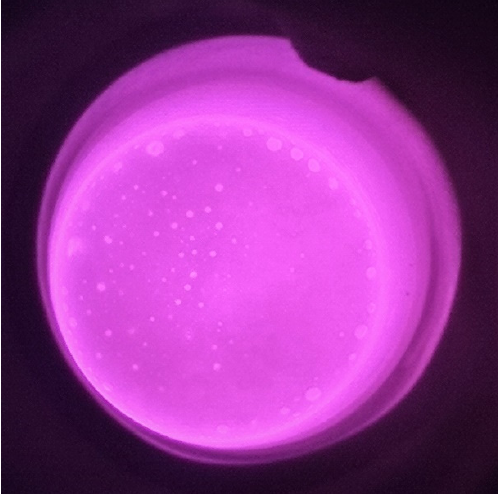
Figure 2. Direct monitoring of the slag/steel interaction. Table 1. Chemical composition of pre-melted steel Sample A (mass percentage).